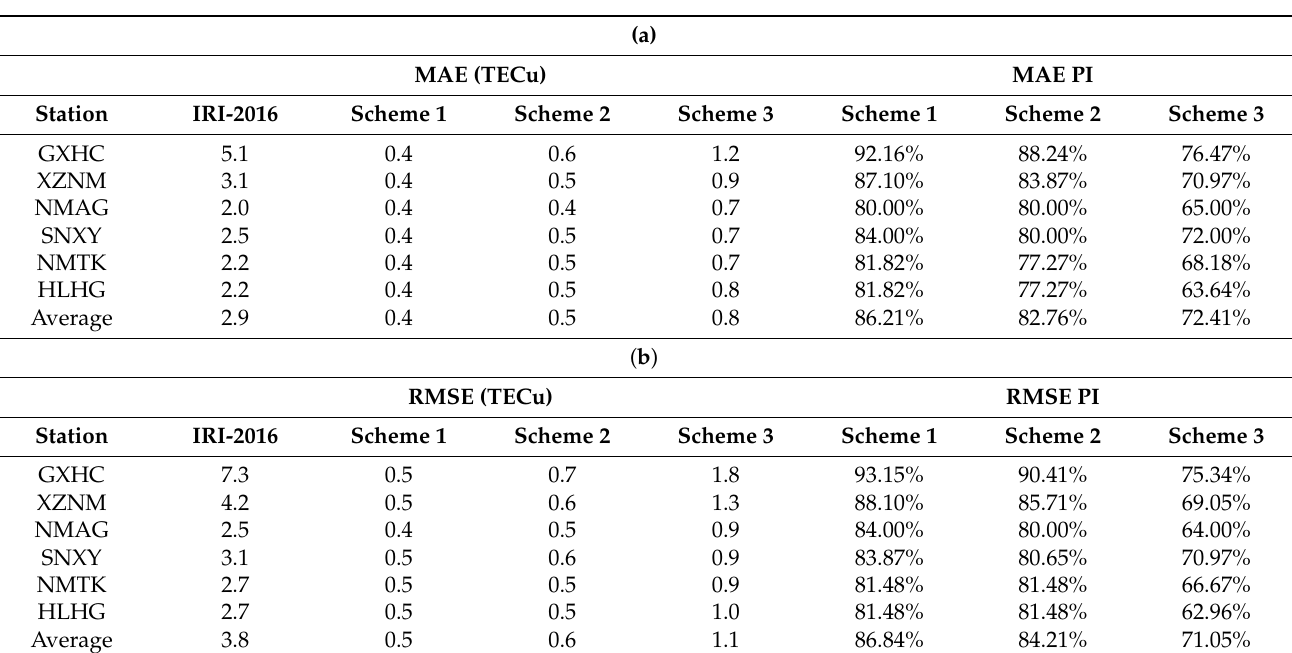
Table 2. ( a ). MAEs and MAE PIs for the TEC in 2019. ( b ). RMSEs and RMSE PIs for the TEC in 2019.